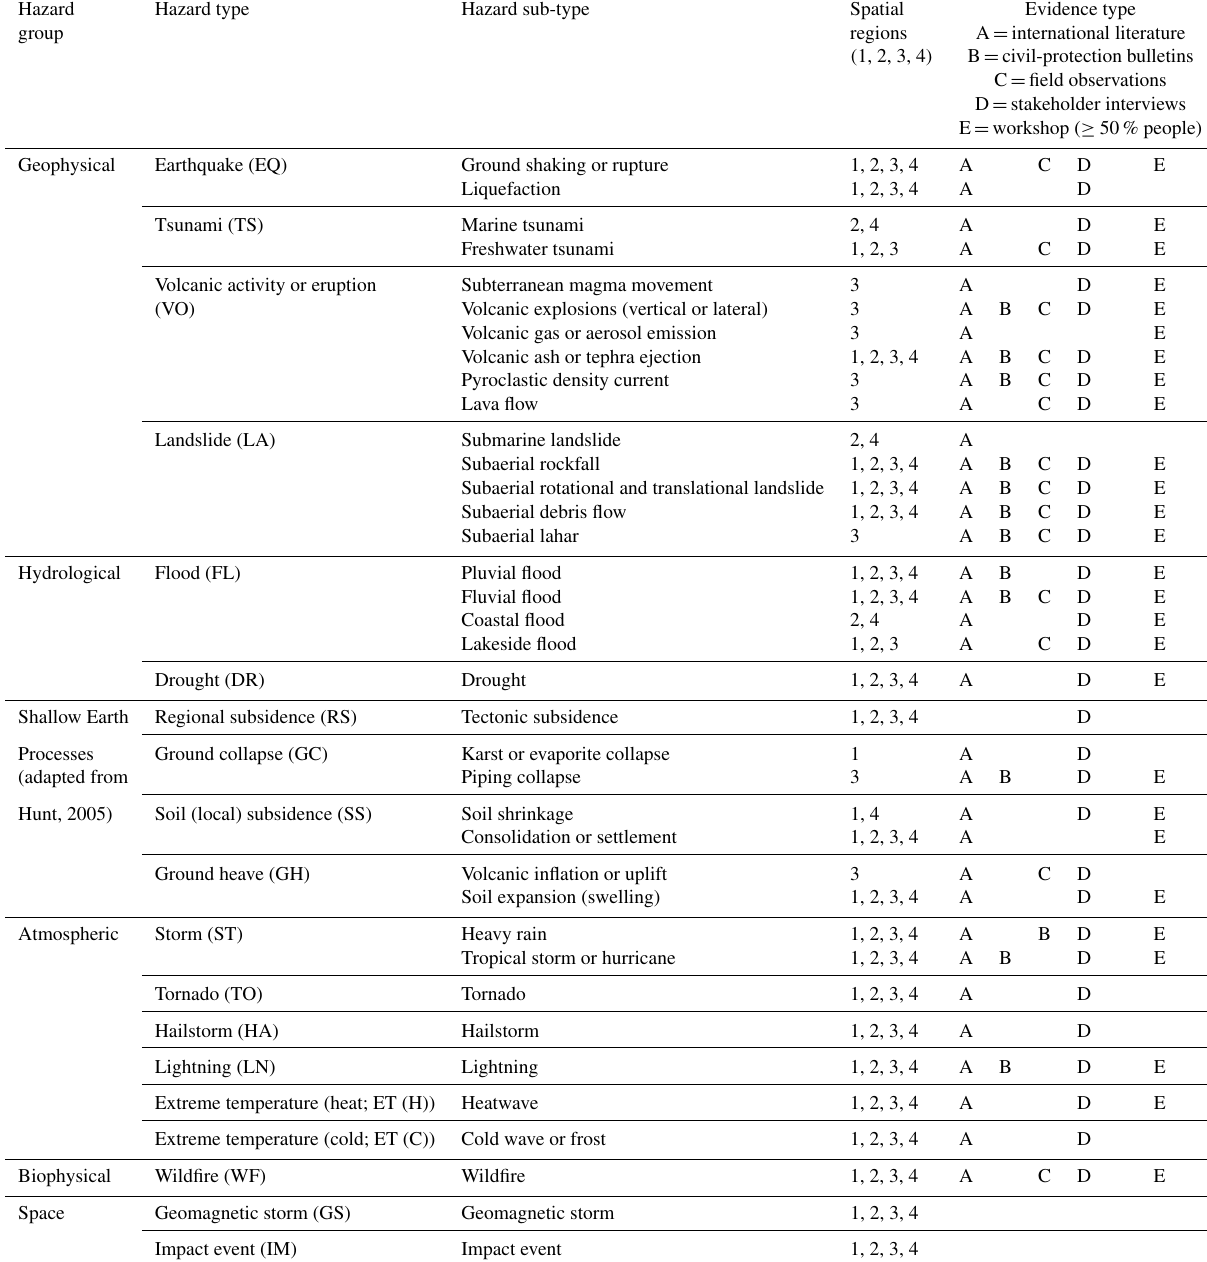
Table 5. Spatial distribution of 37 natural-hazard sub-types in Guatemala. A synthesis table to characterise which regions in Guatemala are susceptible to each of the 37 natural-hazard sub-types. Selected regions (see Fig. 1) are (1) low-relief northern plateaus, (2) central Guatemalan Highlands, with deep valleys, (3) southern Guatemalan Highlands, and (4) Pacific Coastal